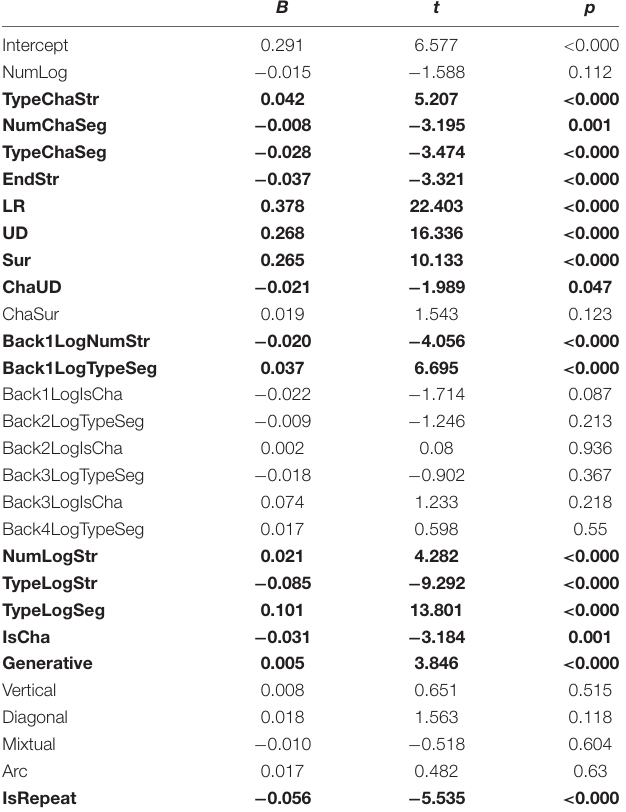
TABLE 4 | Results of regression on